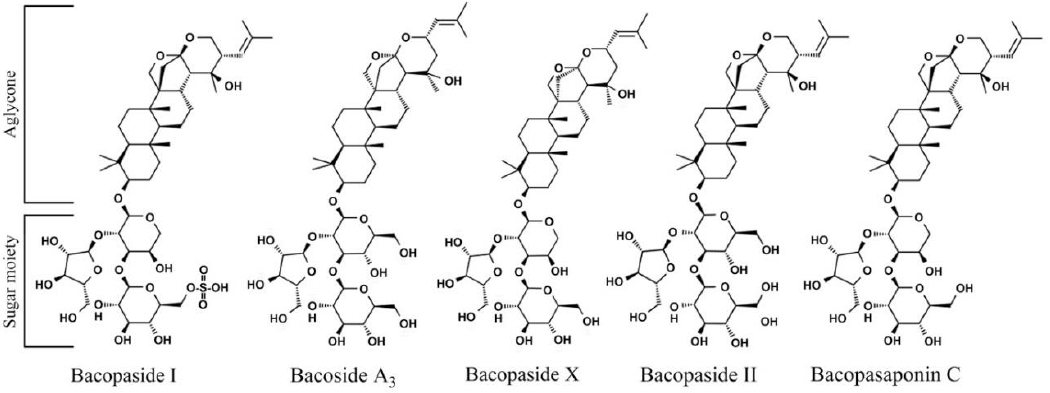
Figure 11. Structures of major components present in extracts from B. monnieri. Structures were prepared with ChemDraw Ultra, version 12.